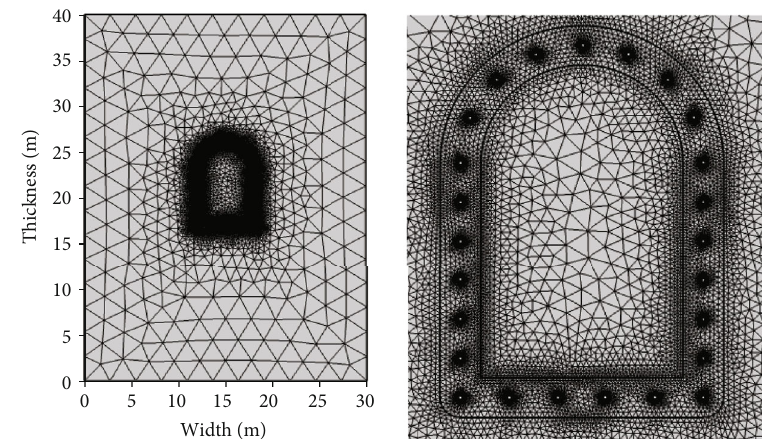
Figure 3: Numerical simulation model and its